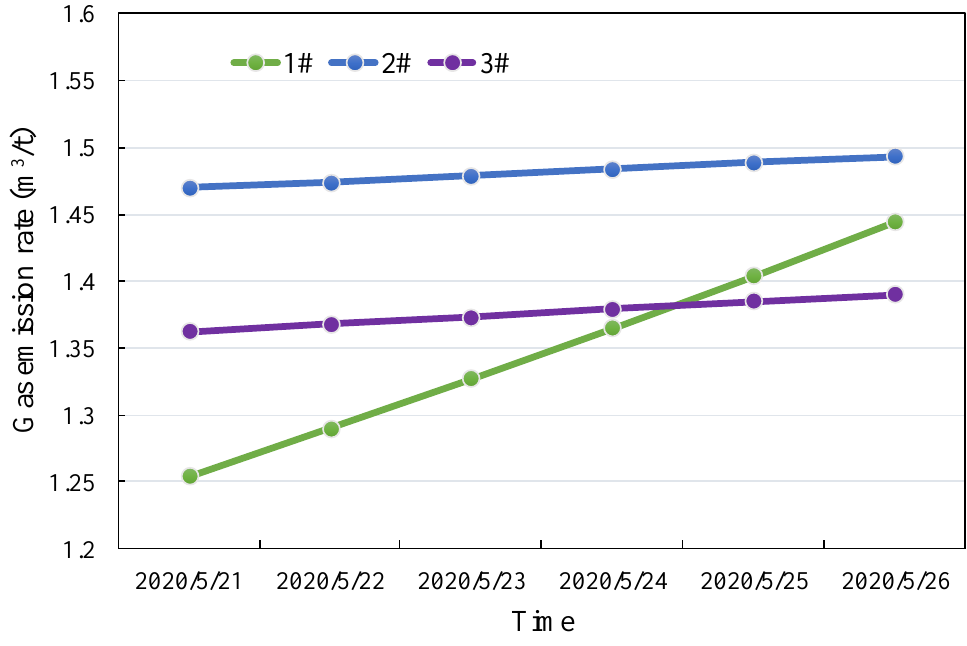
Figure 4. Analysis of coal mining face gas prediction data.